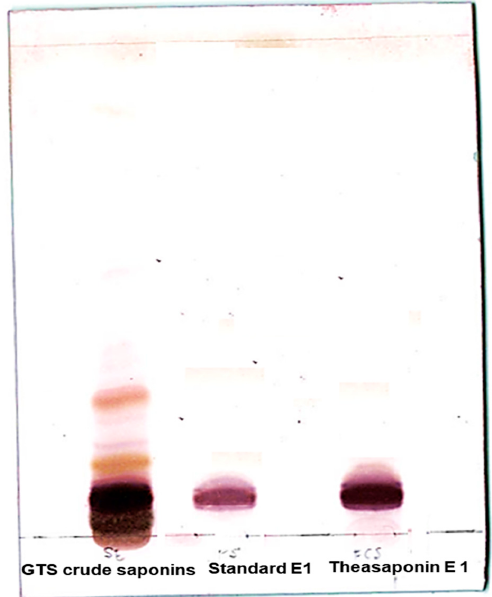
Figure 2. Thin layer chromatography (TLC) of the green tea seed extracted saponin mixture and the purified isolated theasaponin E1 in comparison with the commercial grade standard theasaponin E1.